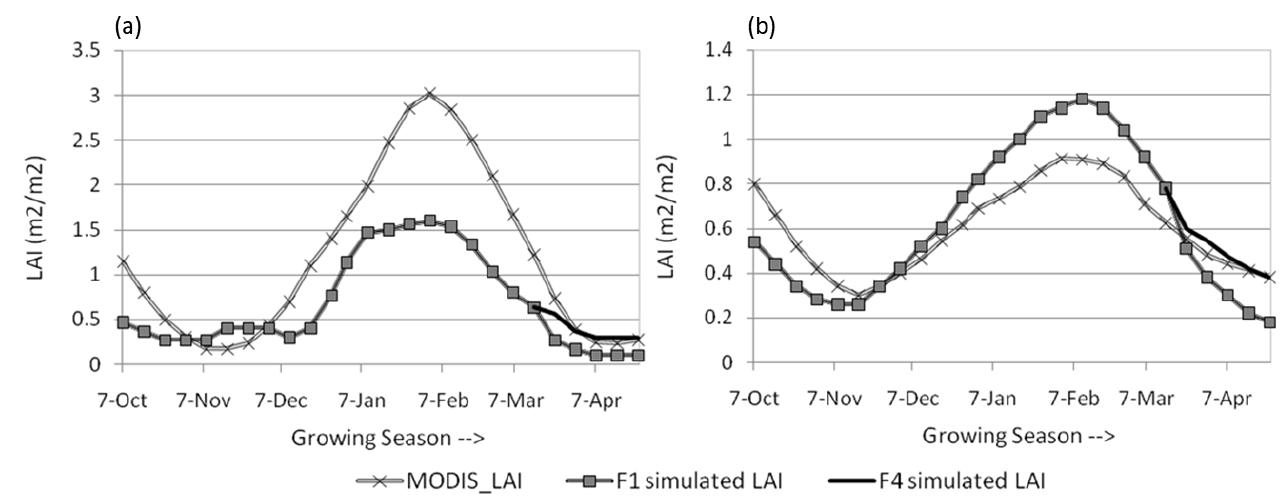
Figure 10. LAI temporal plots for selected districts for the year 2008–2009. ( a ) High-yielding district (Sangrur) LAI temporal profile; ( b ) Low-yielding district (Rupnagar) LAI temporal profile.